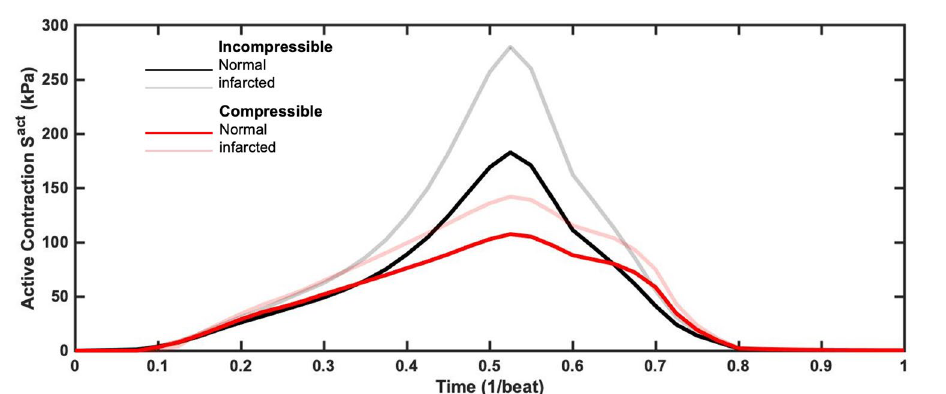
Figure 7. Effect of myocardial infarction and compressibility on active stress distribution within one cardiac cycle. Here, accounting for tissue compressiblity resulted in a pronounced reduction in estimated active myofiber stress in both the pre- and post-MI